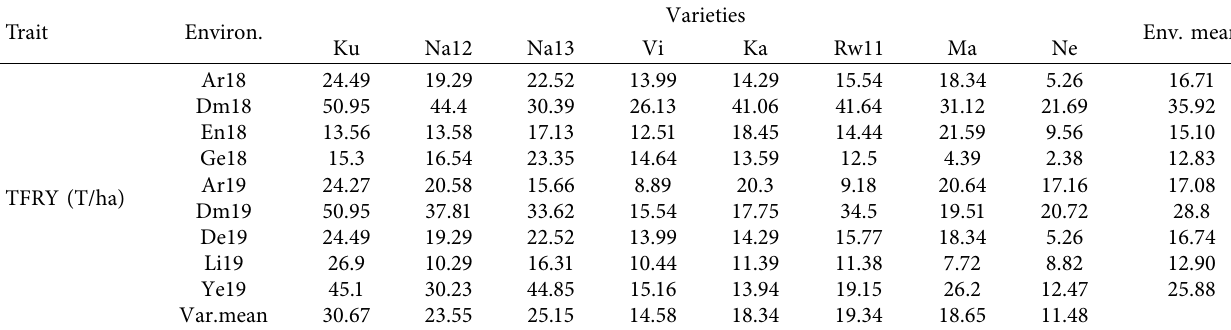
Table 4: Interaction BlUP mean of TTRY over two growing seasons.